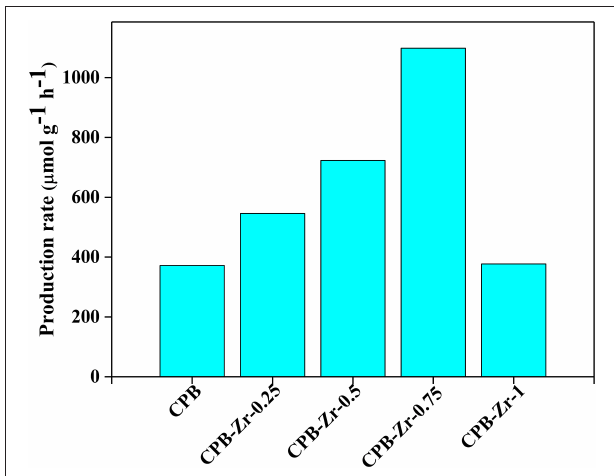
FIGURE 5 | Summarized catalytic activities of CPB and CPB-Zr- x ( x = 0.25, 0.5, 0.75, 1).